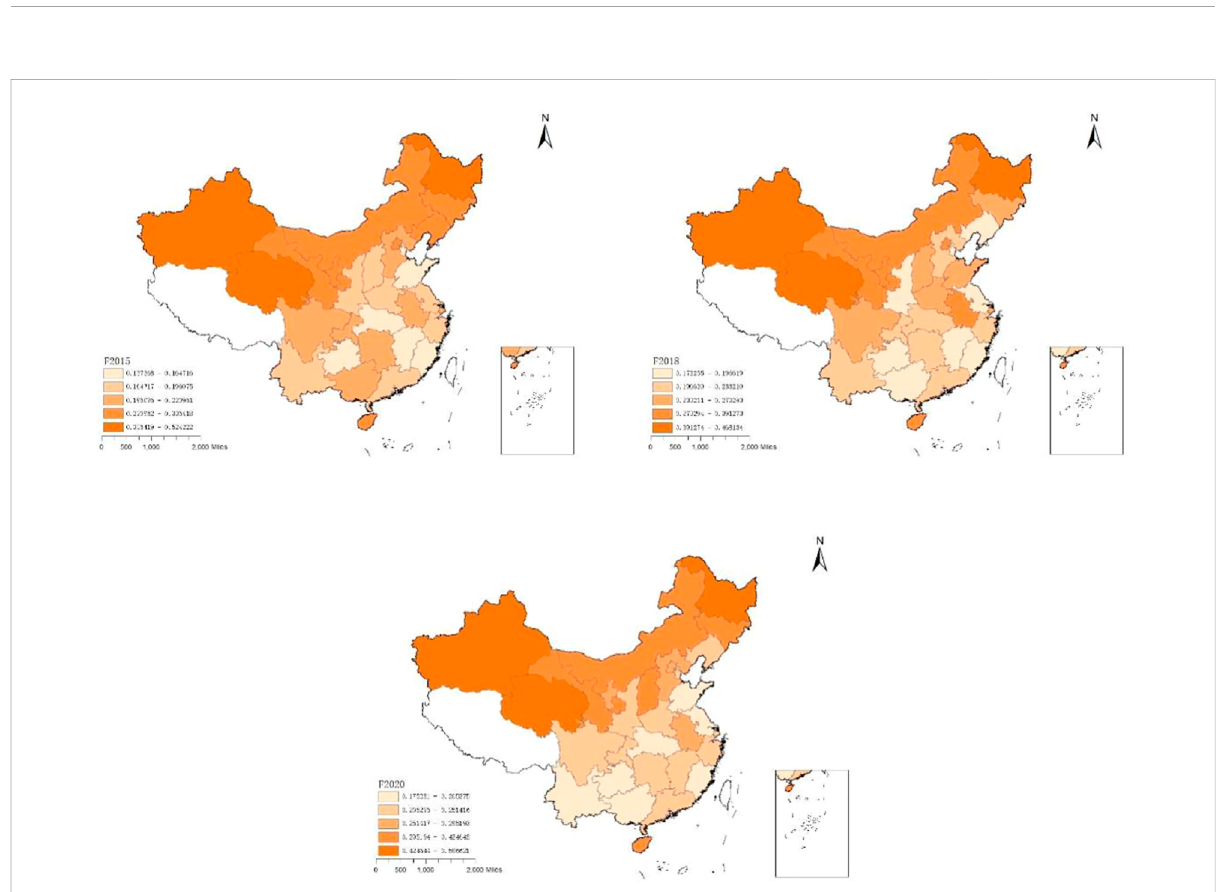
FIGURE 1 Spatial distribution of China ’ s green fi nance development